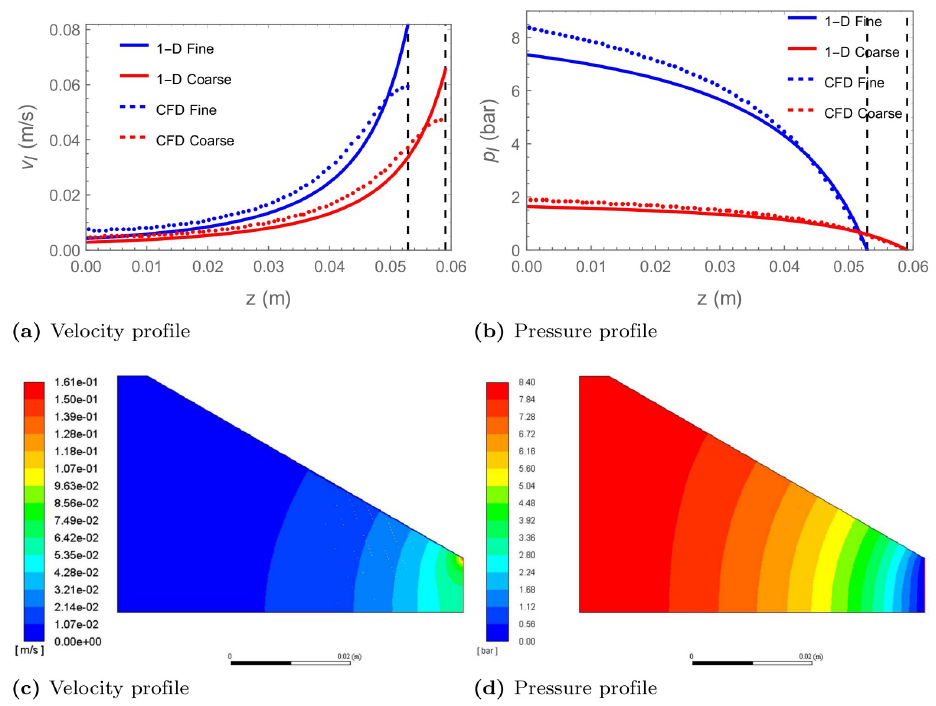
Fig 7. Liquid velocity and pressure profiles conical case. Velocity and pressure profiles of the liquid observed in the 1-D cone model (solid line) and in the CFD model at the centre line of cone (dashed lines) for fine and coarse grinds ((a) and (b)). Velocity and pressure profiles of the liquid observed for fine coffee within the CFD model ((c) and